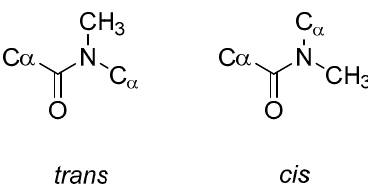
Figure 14. Comparison of the trans and cis conformations of N -methylated peptide bonds.